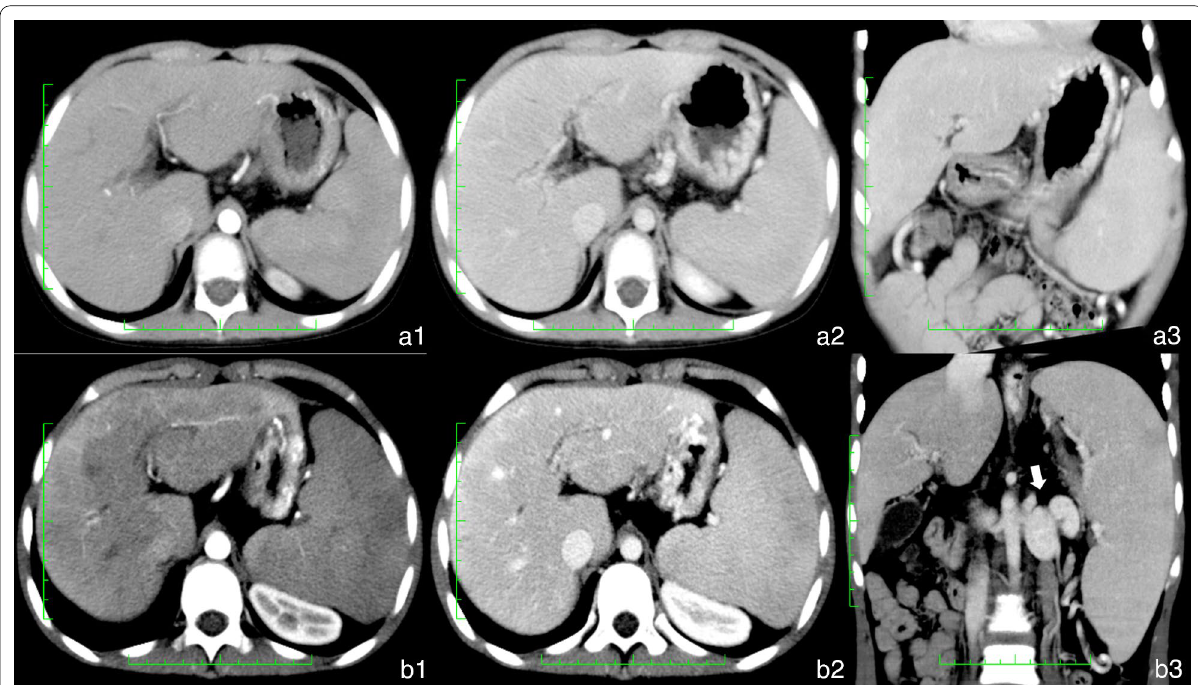
Fig. 5 Male patient aged 6 years 4 months with a 3-year history of repeated hematemesis. a Complete loss of vascular landmarks of the Rex recess (type 4). The patient underwent the Warren procedure. b Computed tomography angiography after 56 months. Complete loss of vascular landmarks of the Rex recess. b3 The spleen–kidney vein anastomosis and the spleen were larger than